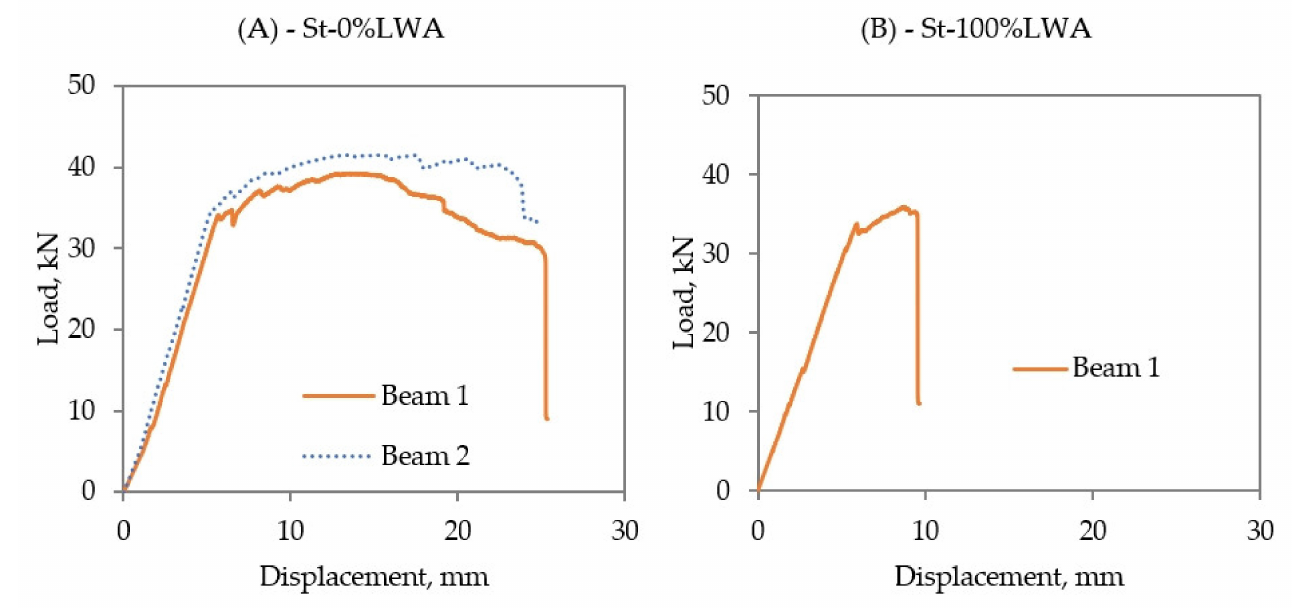
Figure 6. Load–displacement relationship of ( A ) St-0%LWA, and ( B ) St-100%LWA beams. Both Gf-0%LWA and Gf-100%LWA faced a sudden concrete crushing failure after reaching the maximum load (Figure 7). This behavior is in accordance with the results of Junaid et al. [41]. In the case of Gf-0%LWA beams, the first cracking load was approximately 8 kN and the corresponding displacement was around 3 mm, however, the maximum reached load at failure was 31.98 kN with a mid-span deflection of 7.59 mm. The initial cracking load of Gf-100%LWA beams was the same as Gf-0%LWA beams, where the first cracking load was around 8 kN with a displacement of around 3 mm. The failure load of Gf-100%LWA beams was 26.58 kN with a mid-span deflection of 7.51 mm.